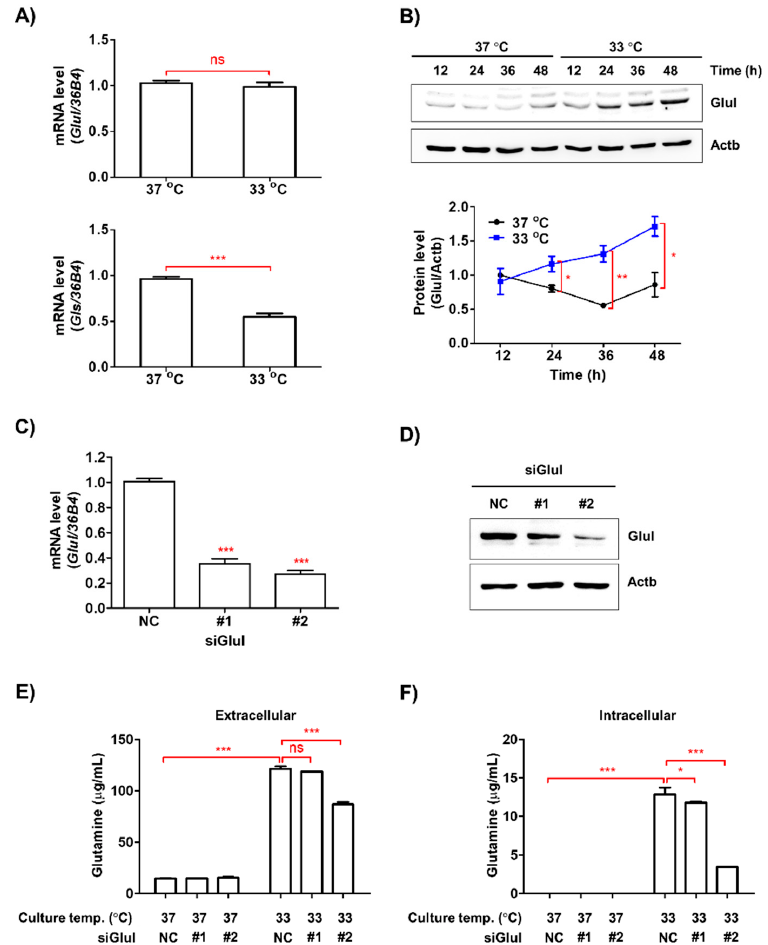
Figure 5. Knockdown of Glul decreased glutamine levels in macrophages exposed to low temperature. ( A ) RAW264.7 cells were incubated at 33 °C or 37 °C for 48 h. The mRNA expression levels of Glul and Gls were determined by qRT-PCR. 36B4 was used as an internal control. ( B ) The protein levels of Glul in RAW264.7 cells were measured by Western blotting analysis. Actin was used as a loading control. ( C , D ) Glul expression levels in the RAW264.7 cells transfected with scramble siRNA (NC) or two specific siRNA (#1 and #2) for Glul were determined by qRT-PCR and Western blotting analyses. ( E , F ) Glutamine levels in CM ( E ) and cell lysates ( F ) of Glul siRNA-transfected RAW264.7 cells were measured using HPLC analysis. Data are expressed as the mean ± SD. * p < 0.05, ** p < 0.01, and *** p < 0.001 compared to the control (37 °C). ns means no significance.